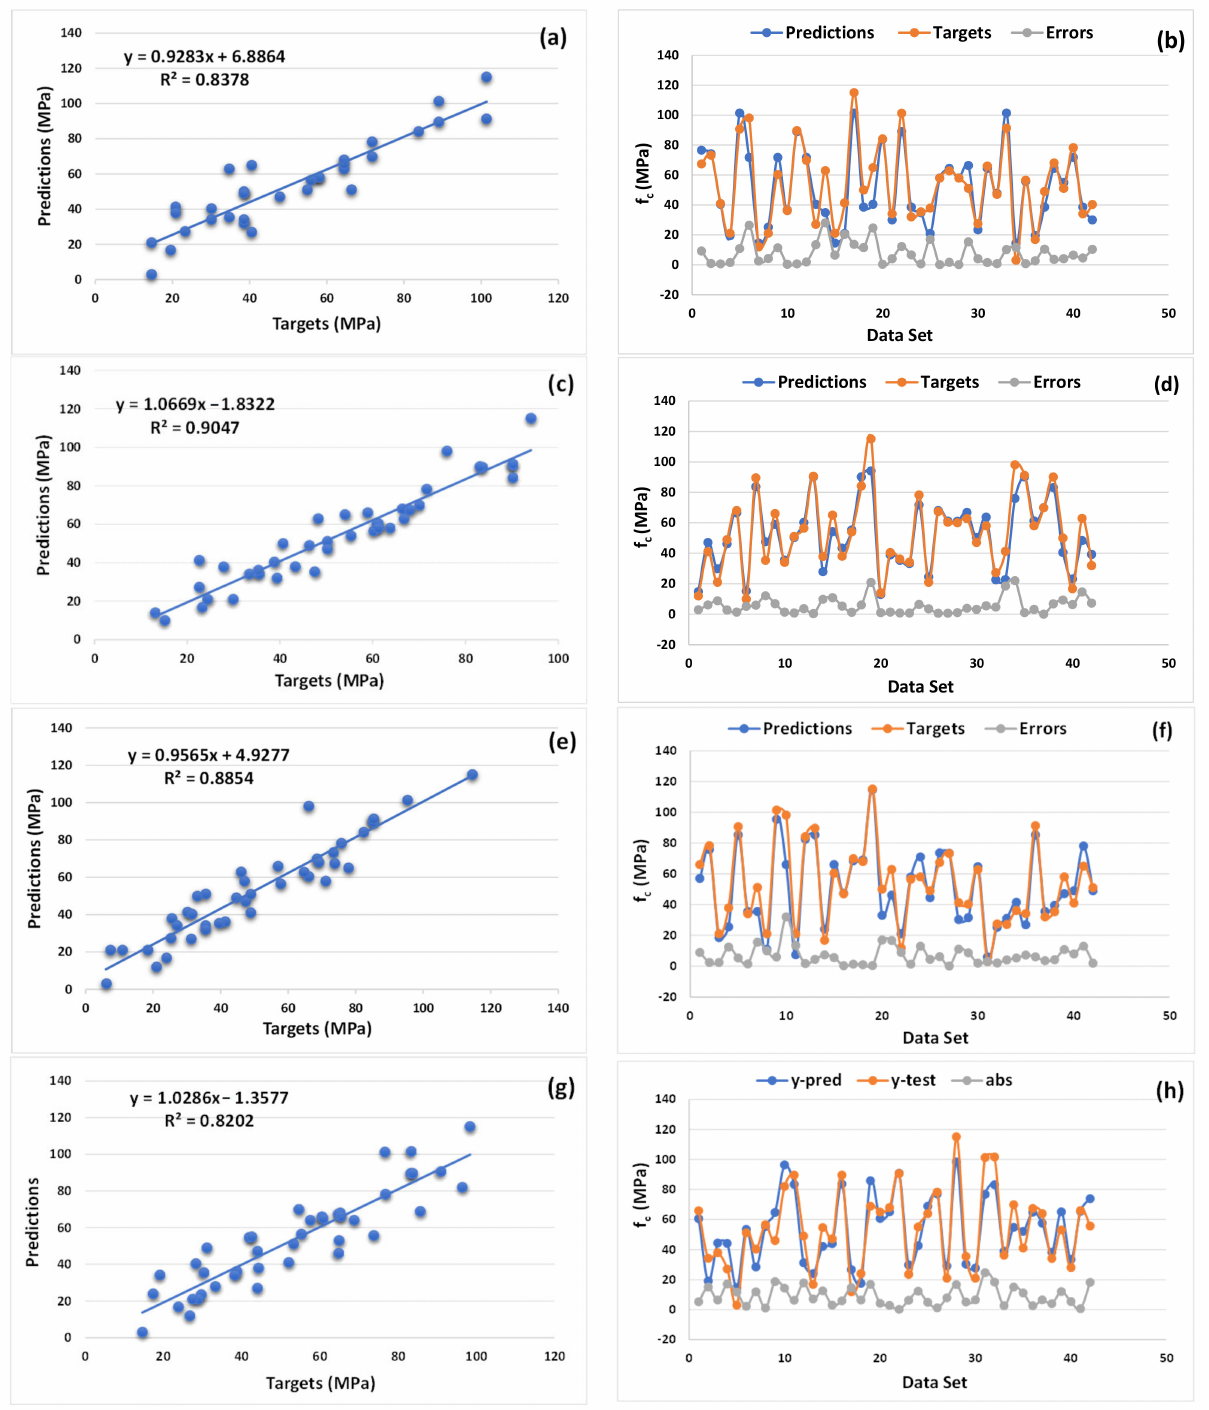
Figure 3. Numerical analysis results showing the relationship between the actual and predicted results, including the error distribution of models: DT ( a , b ); bagging ( c , d ); GB ( e , f ), ANN ( g , h